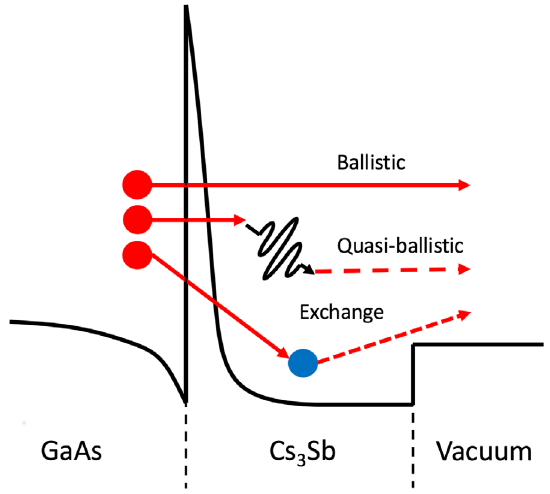
FIG. 8. Schematic representation of the three different proc- esses leading to the extraction of photoelectrons from GaAs, through the Cs 3 Sb layer into vacuum. Ballistic hot electrons travel trough the activation layer without interaction with lattice or electrons; quasi-ballistic electrons can be still extracted if few scattering events take place so that they have sufficient energy to overcome the barrier to vacuum; hot electrons can exchange energy with low energy electrons and give them sufficient energy to escape into